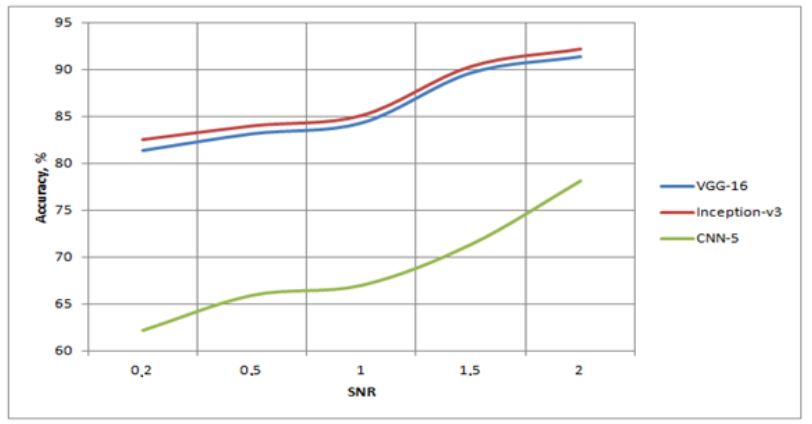
Figure 7. Dependence of accuracy on noise level in Attack No. 1.